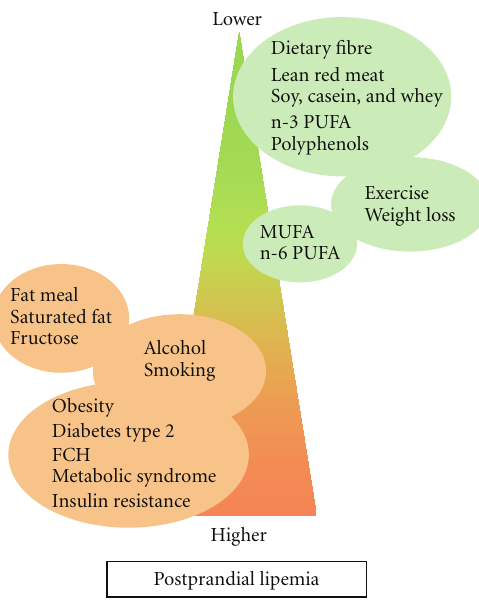
Figure 2: Influence of metabolic diseases and lifestyle factors on postprandial lipemia: factors listed in green circles reduce postprandial lipemia, whereas the factors in red have detrimental e ff ects on postprandial